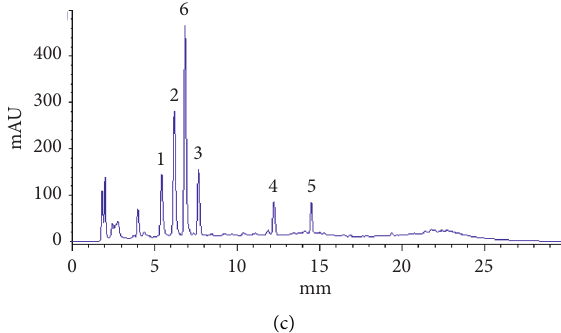
Figure 8: Chromatogram of standard reference and EAE (4mg/mL). (a) Chromatogram of mixed standard reference. (b) Chromatogram of kaempferol-3-o-rutoside standard reference. (c) Chromatogram of EAE: 1, rutin; 2, isoquercetin; 3, astragaloside; 4, quercetin; 5, kaempferol; 6,